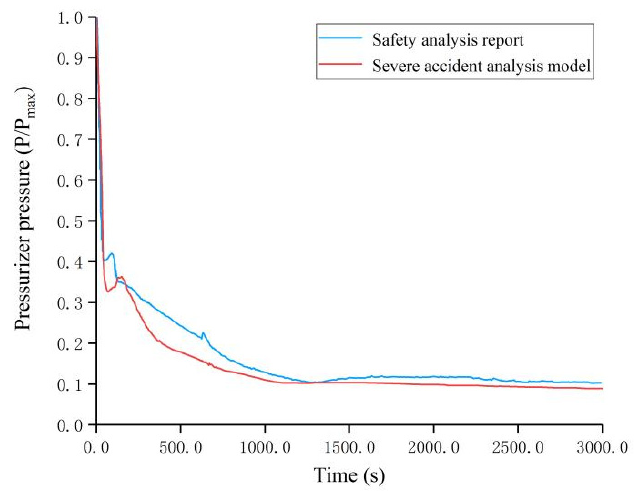
Figure 3. The variation curve of the pressurizer pressure over time.